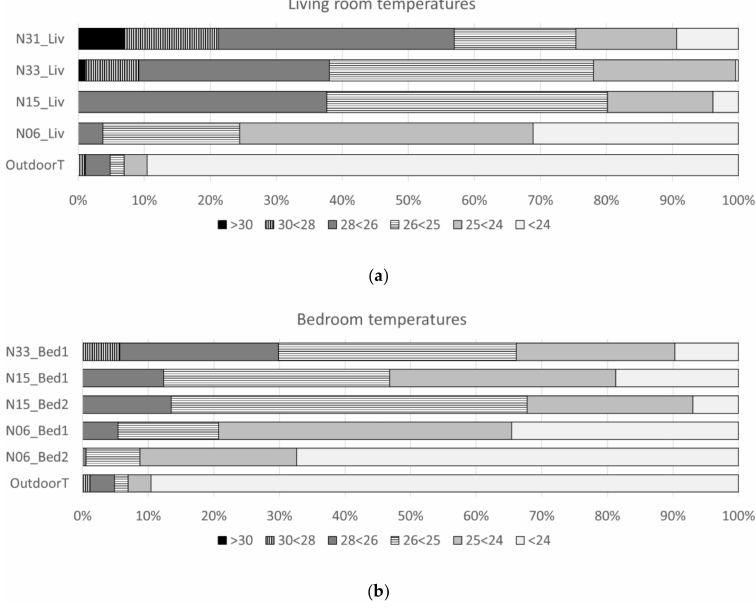
Figure 11. Temperature ranges in living rooms ( a ) and bedrooms ( b